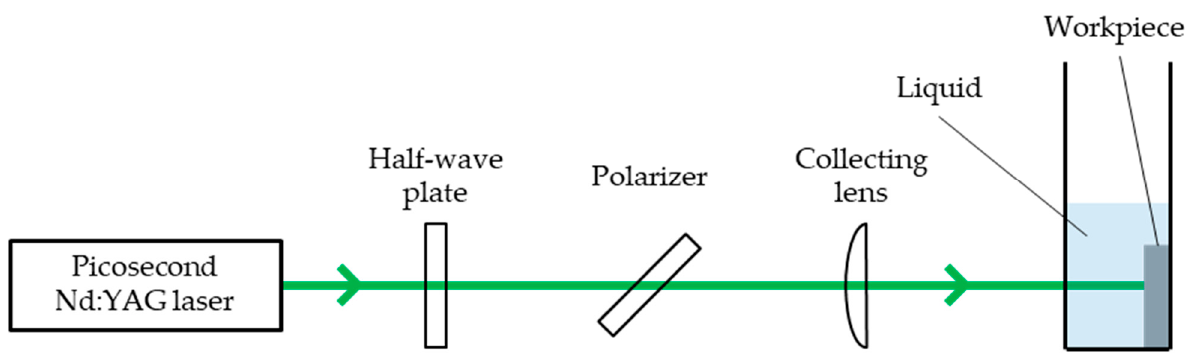
Figure 1. Schematic diagram of the experimental setup for laser irradiation on the material surface set vertically to the ground.